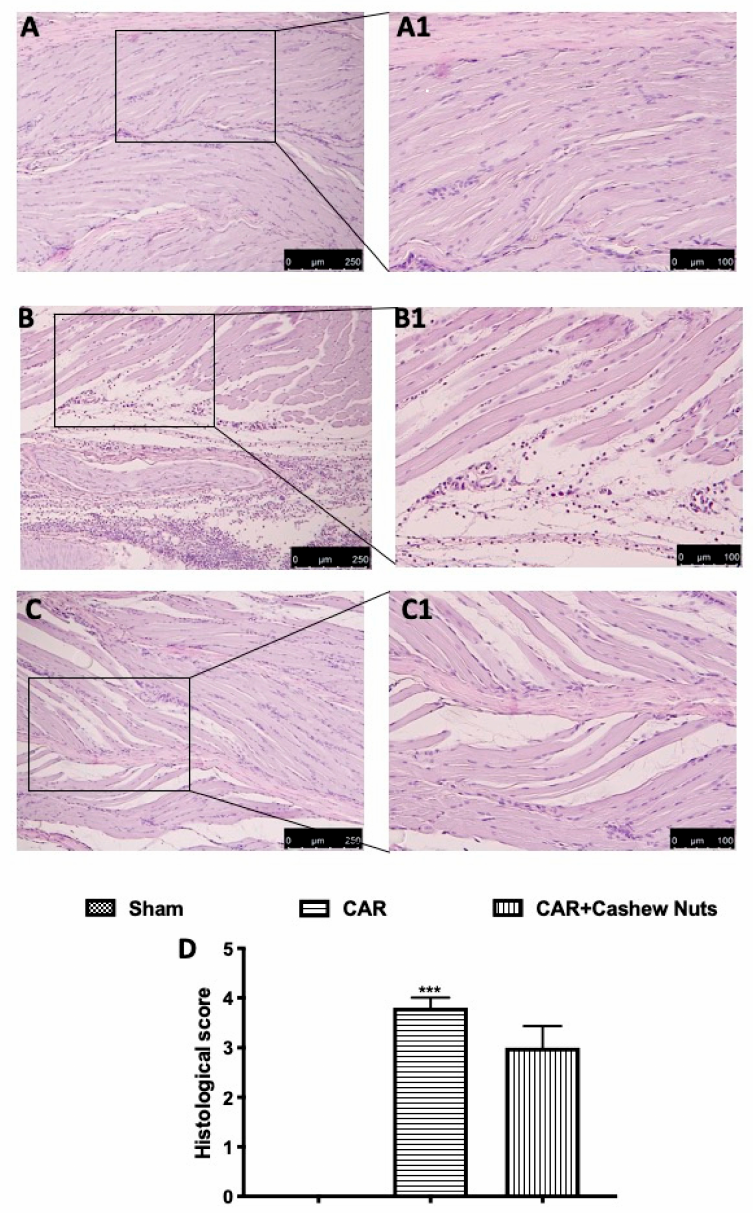
Figure 2. Histological evaluation of paw tissue after cashew nuts treatment following CAR-injection. Investigation of tissue injury of the animals subjected to CAR, was made by H / E staining. CAR group shows a loss of the physiological architecture compared to sham. Cashew nuts administered 30 min before CAR-injection shows reduction in infiltrating cells and edema formation compared to vehicle. Histological score ( D ). See materials and methods for further details. Sham ( A , A1 ); CAR ( B , B1 ); cashew nuts ( C , C1 ). *** p < 0.001 vs.